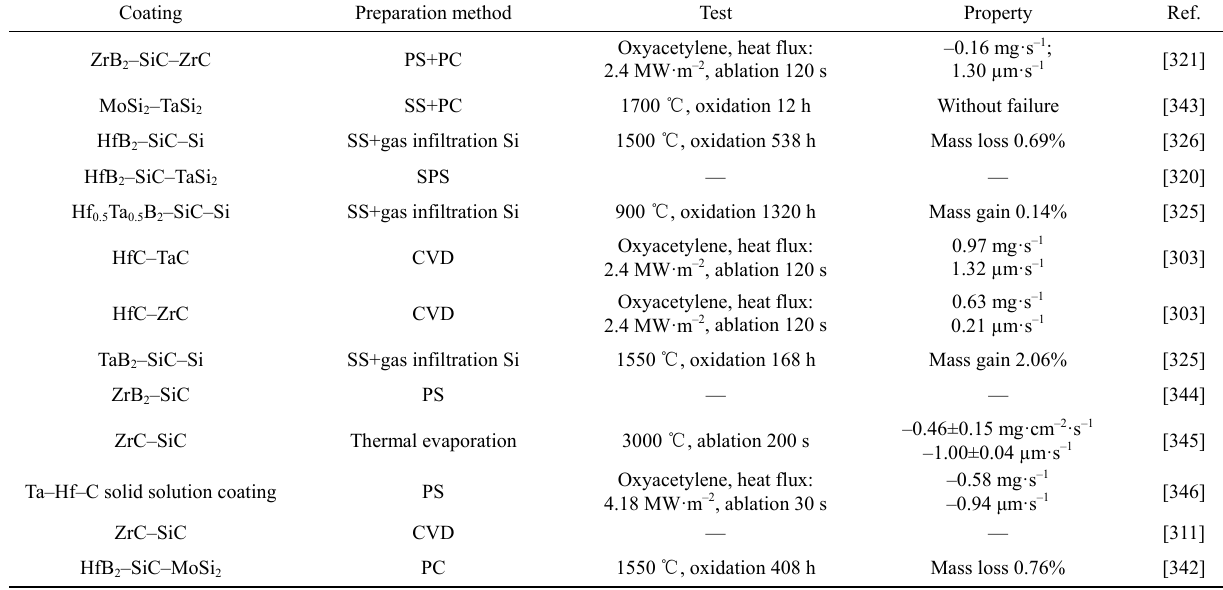
Table 5 Preparation methods and properties of various multiphase UHTC